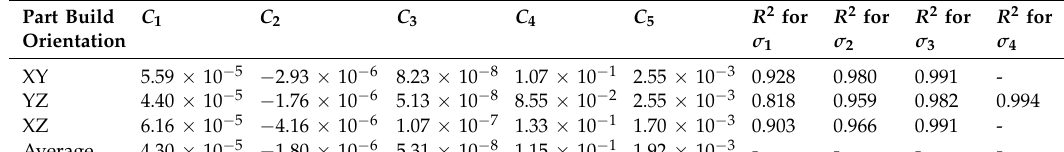
Table 7. Adjusted parameters ( C x ) for the generalized time hardening equation (see Equation (1)) along with the coefficient of determination ( R 2 ). Coefficients must be multiplied by the exponential terms.